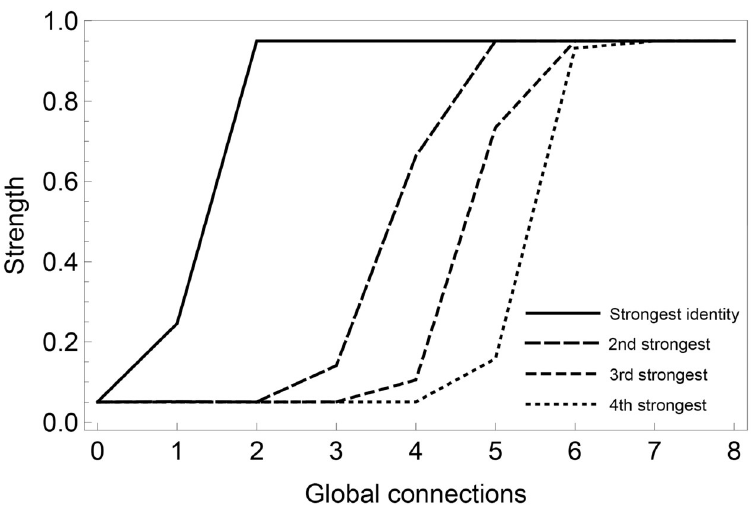
Fig 3. Transitions between regimes. Transitions to one or several dominating identities are shown as a function of the ). The plot is based on 50 simulations for each value of n , with averages of final number of global connections ( n glob glob strength values plotted in the graph. We use N = 200 individuals and each run is 200,000 time steps, i.e., individual reinforcement learning steps. For each run, the M = 4 different identities are represented by full to dotted lines in their order of dominance. The graph illustrates that, when the local neighborhoods are dominating (smaller number of global connections), only zero or one of the identities develops towards high identity strengths. When connections can be chosen freely (larger number of global connections), a larger number of the identities achieve higher strength values.